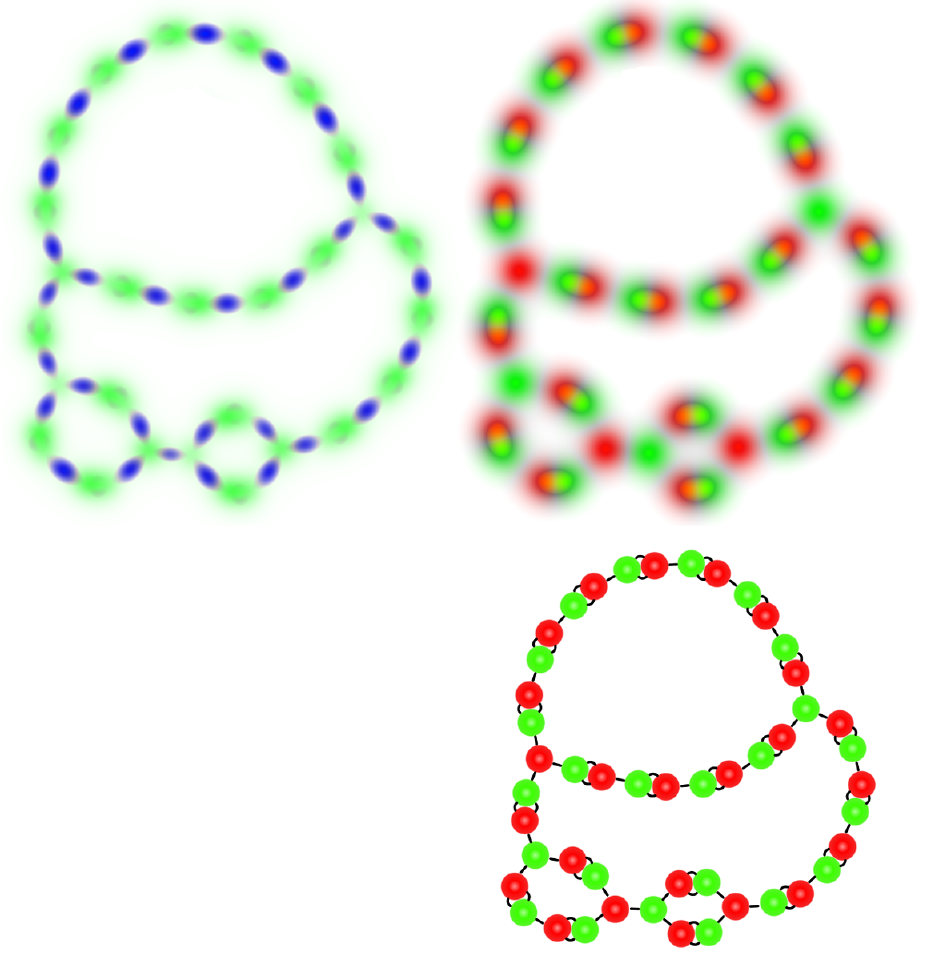
Figure 11 : ( Q 1 ; Q 2 ) = (3 ; 3) nonminimal vortex ring network. The (cid:12)gure contains 3 elements from left to right and then down: an energy density plot, a (cid:12)eld density plot and a sketch of how the red and green vortices are interconnected. The (cid:12)rst two plots are made using the coloring scheme of (cid:12)gure